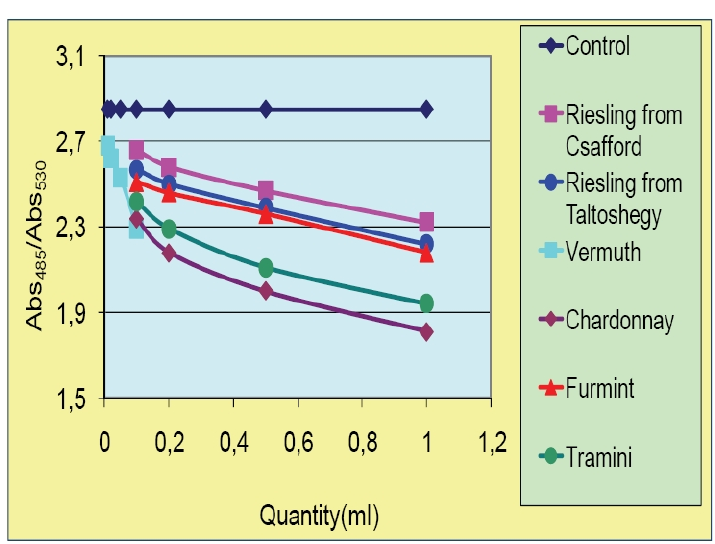
Fig. 3 Complex bilding capacity of some Hungarian vines (based on the data of J. Feher and A. Lugasi).